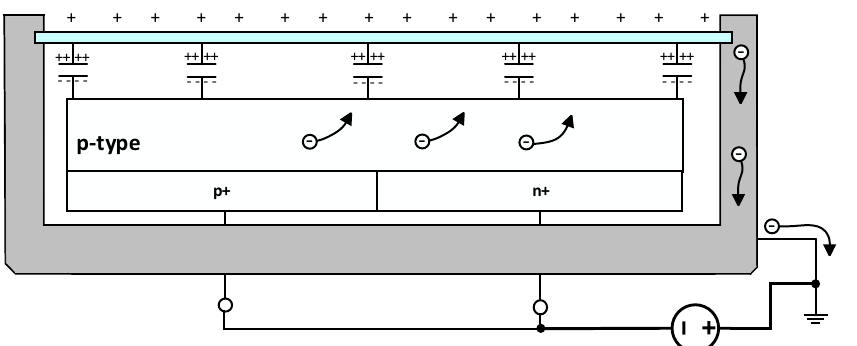
Figure 4. A cross-section of a p-type PV panel when degradation is implemented by the power electronics converter.